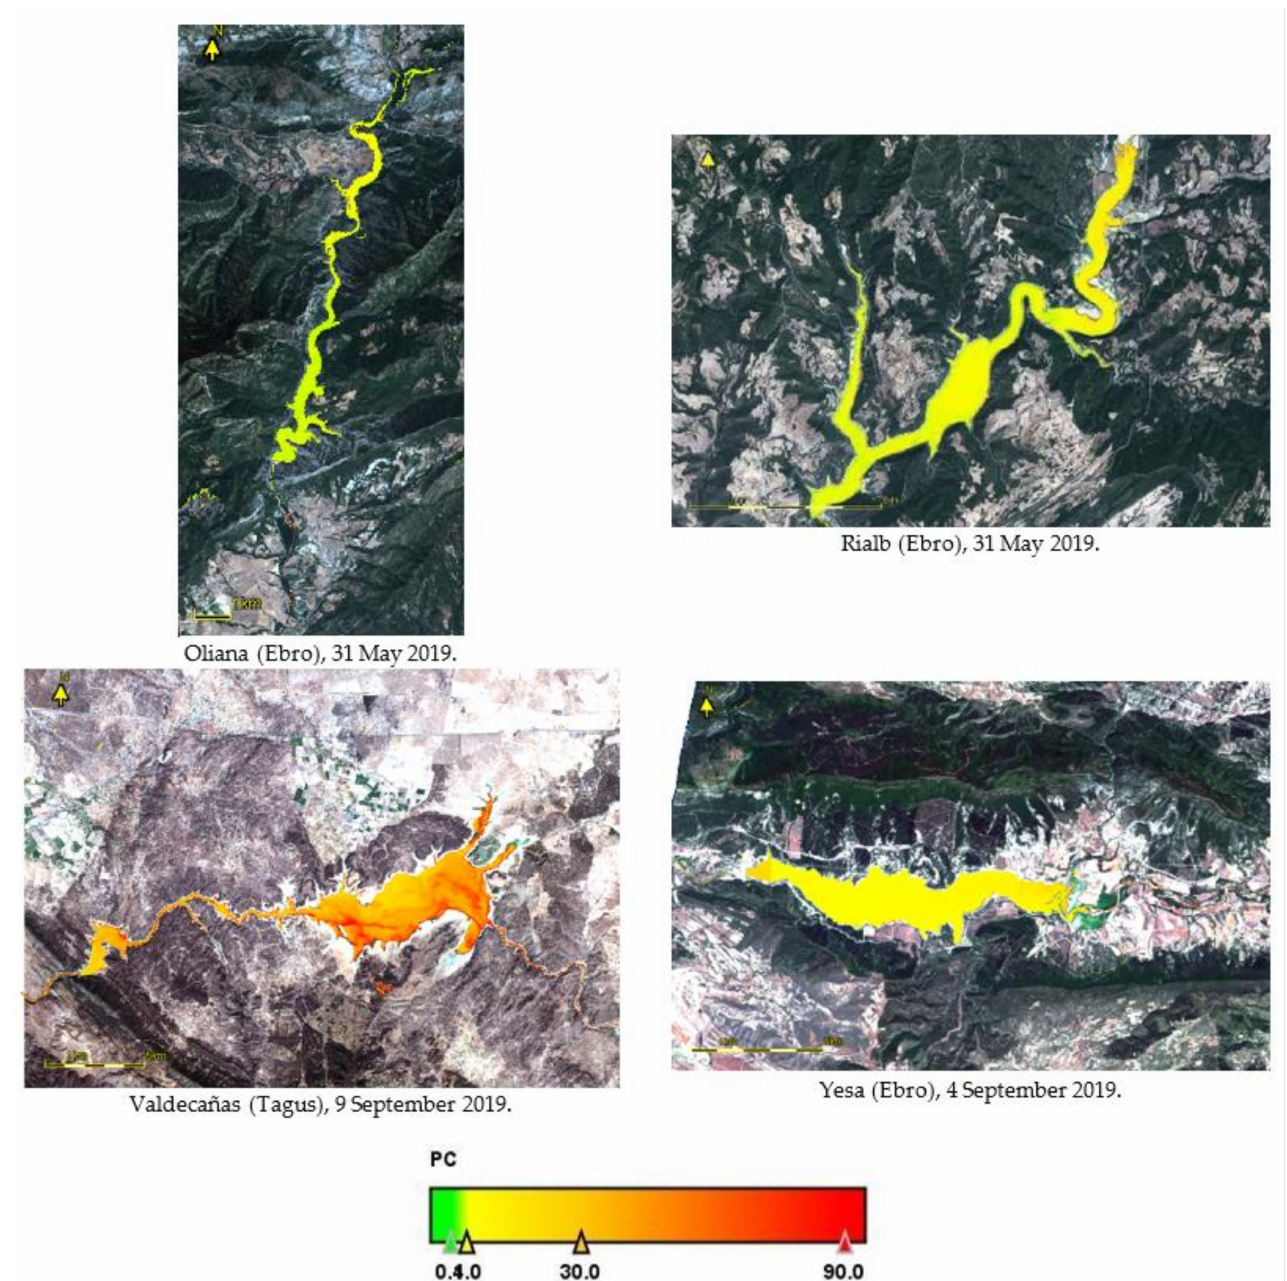
Figure A3. Thematic maps of PC ( µ g L − 1 ) in some reservoirs, showing the alert level in a color scale according to Table 3. For each site, the date of the image and the watersheds are